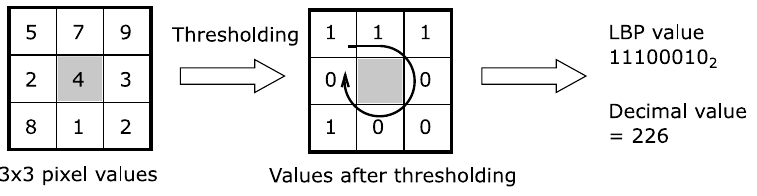
Figure 6. 3 × 3 pixel values LBP